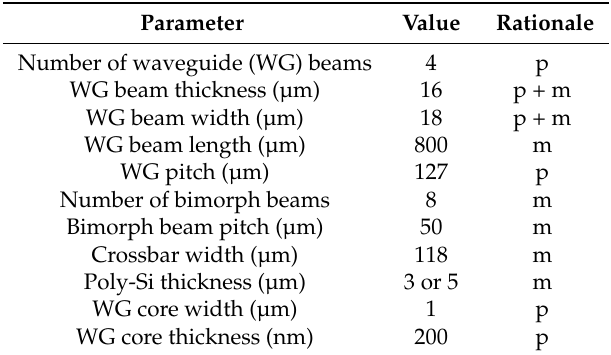
Table 1. Overview of the most important parameters and values used in the suspended beam arrays. The rationale column indicates whether the value is defined by photonic (p) or mechanical (m) requirements.